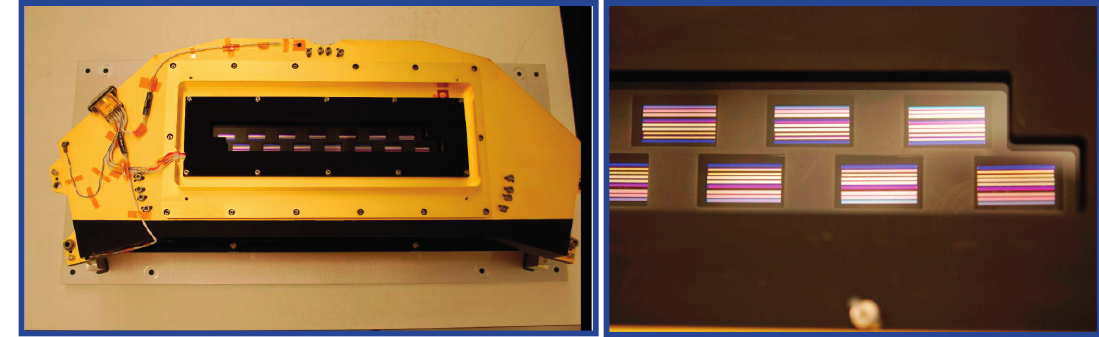
Figure 7. The full focal plane array ( left ); a close up of the focal plane modules, highlighting the spectral filters ( right ).